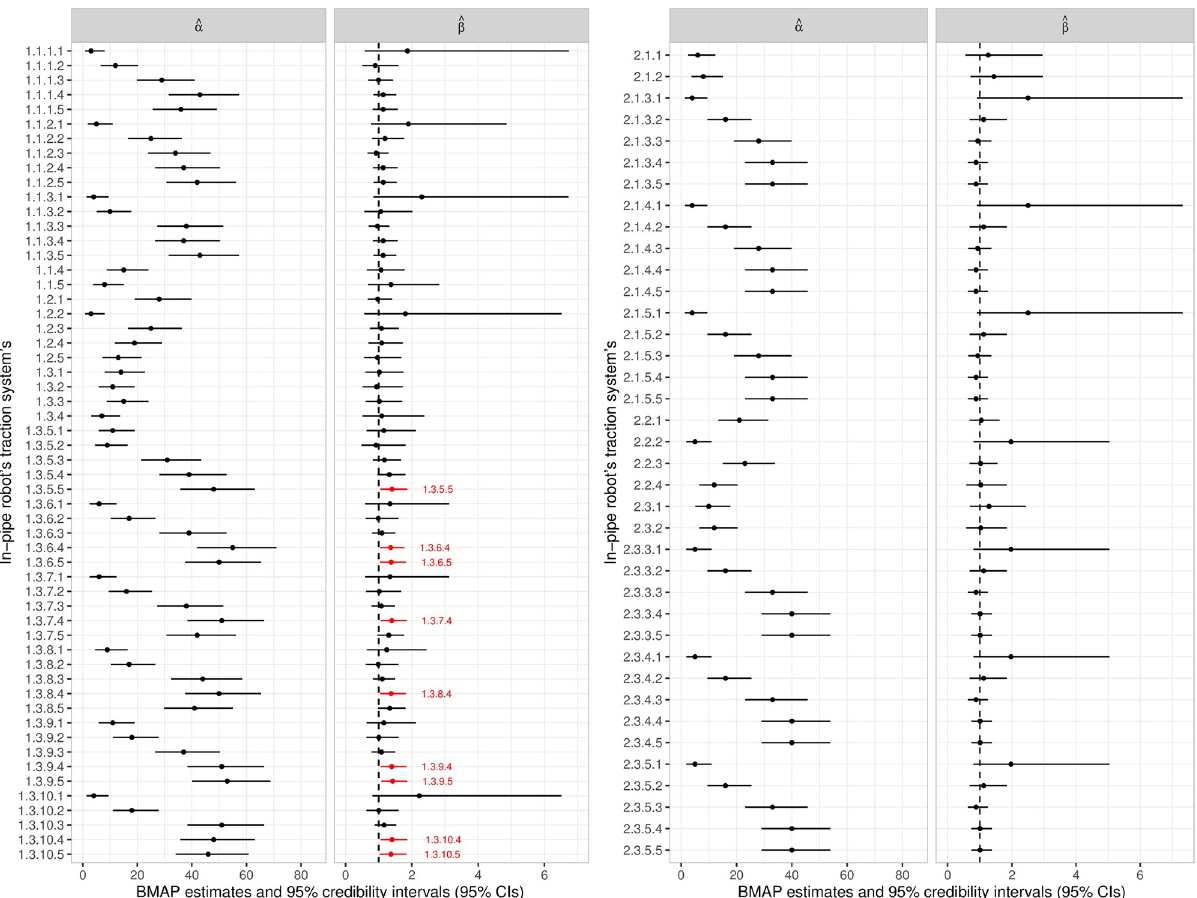
Fig 10. Parameters estimatives for the in-pipe robot’s traction system’s failure data. BMAP estimates and 95% credibility intervals (95% CIs) for the model parameters.